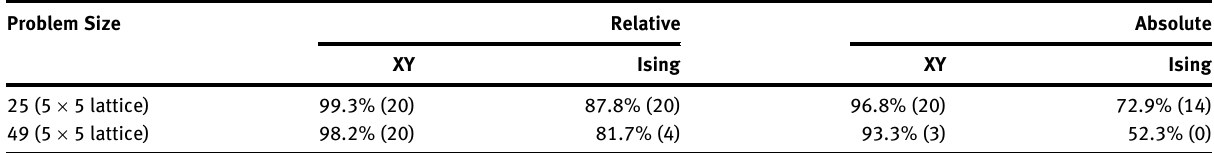
Table  : Optimisation of the Ising and XY spin Hamiltonians with relative and absolute coupling models on unweighted MaxCut problems of size  and  with edge density  .  . The median accuracy of both models is calculated for  random initial conditions per each coupling matrix which was further averaged over  random coupling matrices with coupling strength J  (cid:1)  .  . The number in parentheses indicates how many problems with different coupling matrices were globally optimised. The ground state solutions are calculated with the